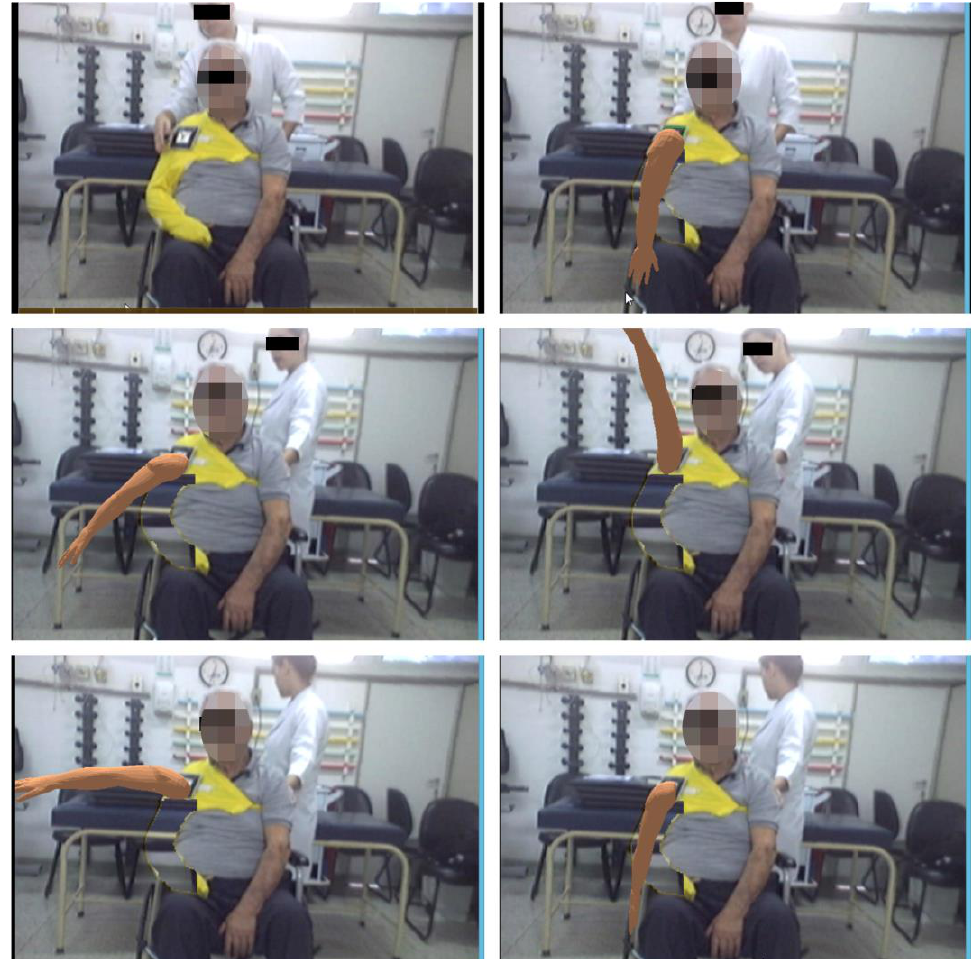
Figure 1. Sequence of frames for shoulder abduction with the NeuroR system. The virtual arm replaces the real, injured arm on the computer screen, which the patient sees as a mirror image. The virtual arm performs a much larger movement than the real movement the patient is actually capable of executing.